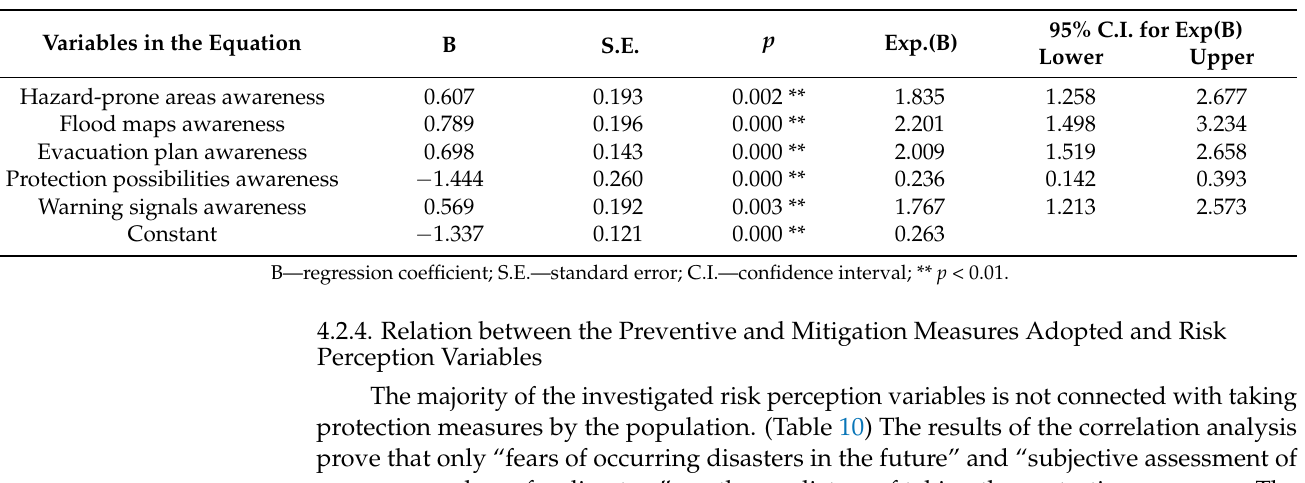
Table 9. Multiple logistic regression analysis investigating factors (disaster awareness variables) relating to respondent’s preventive behaviour and disaster preparedness.